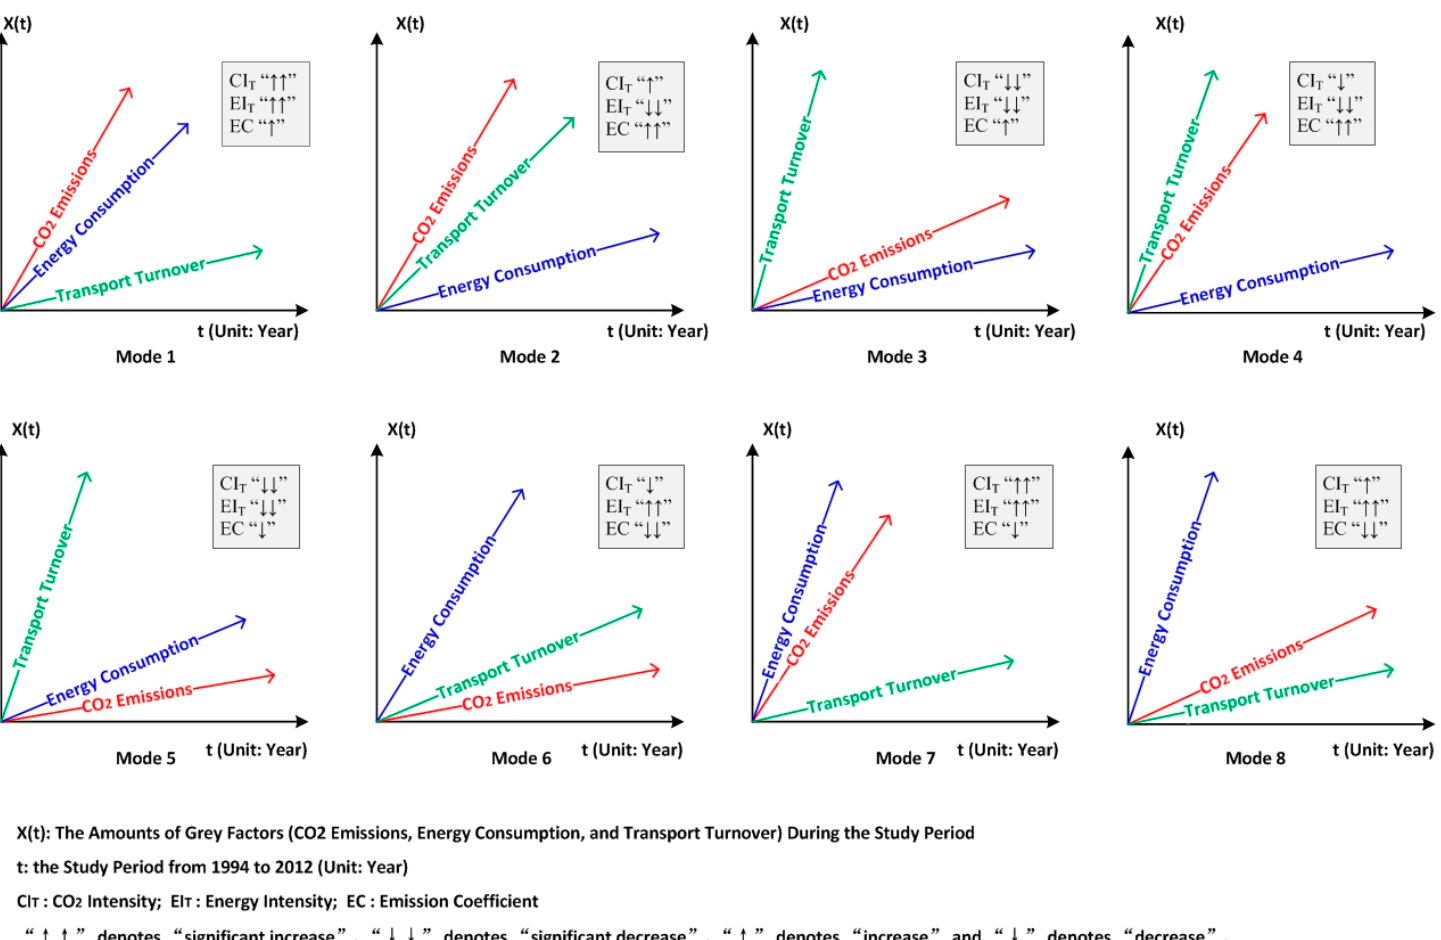
Figure 3. Eight Development Modes of Energy Consumption, CO 2 Emissions and Transport Turnover in China’s Provincial Transportation Sectors.